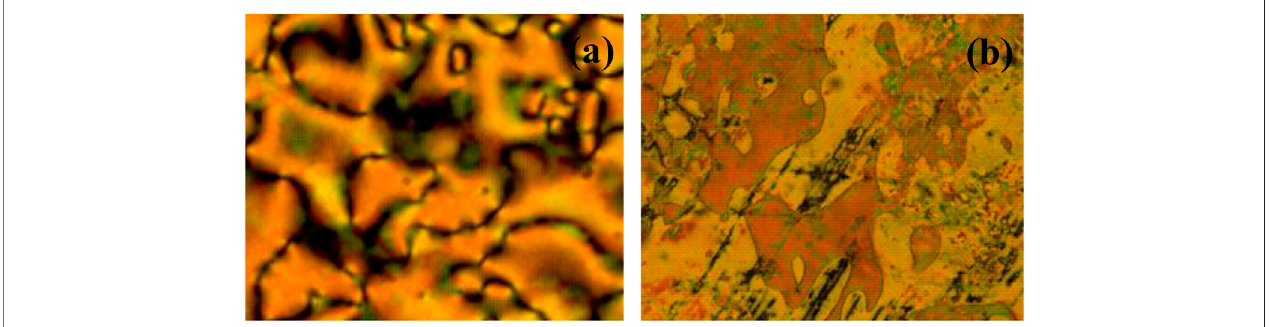
FIGURE 2 | Polarizing Optical Microscopy texture of compounds E8 and E16 on cooling from isotropic liquid under the crossed polarizers: one can see N mesophase at 128 ° C for compound E-8 (A) ; N mesophase at 127 ° C for compound E-16 (B) . Reproduced the part of the fi gure from [18].